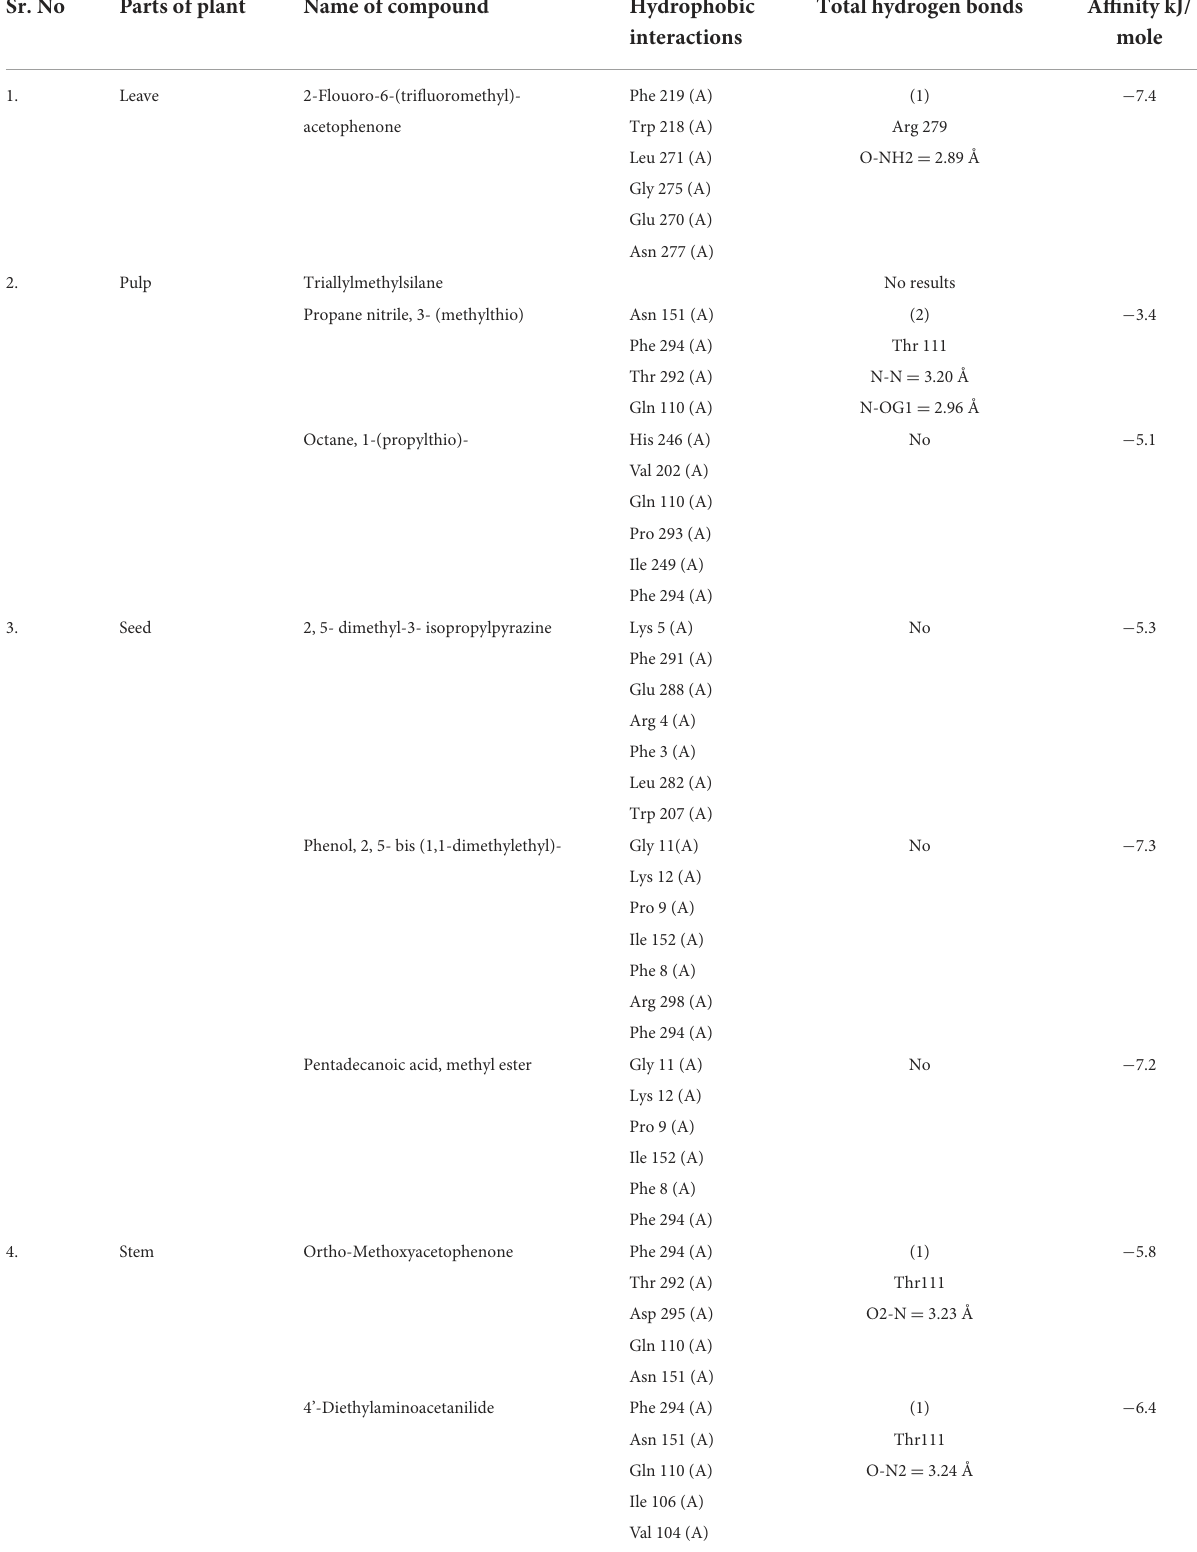
TABLE 3 Summary of docking results of 22 compounds, functional residues involved in hydrophobic interactions, hydrogen bonds, and their binding affinities against 6LU7 target protein. Sr.